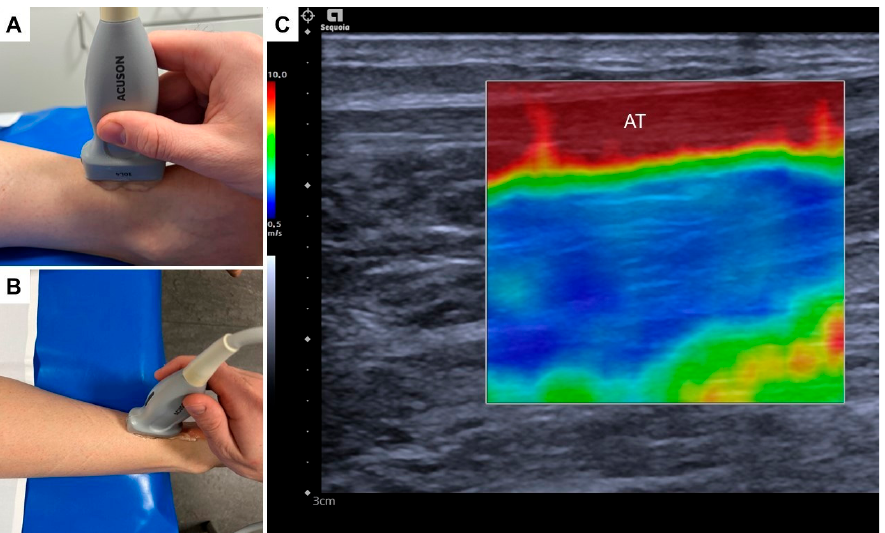
Figure 1. Example of SWE examination of a female athlete in a relaxed prone position with longitu- dinal probe orientation ( A , B ) and corresponding color-coded mapping of SWE ( C ) of the Achilles tendon (AT) in the